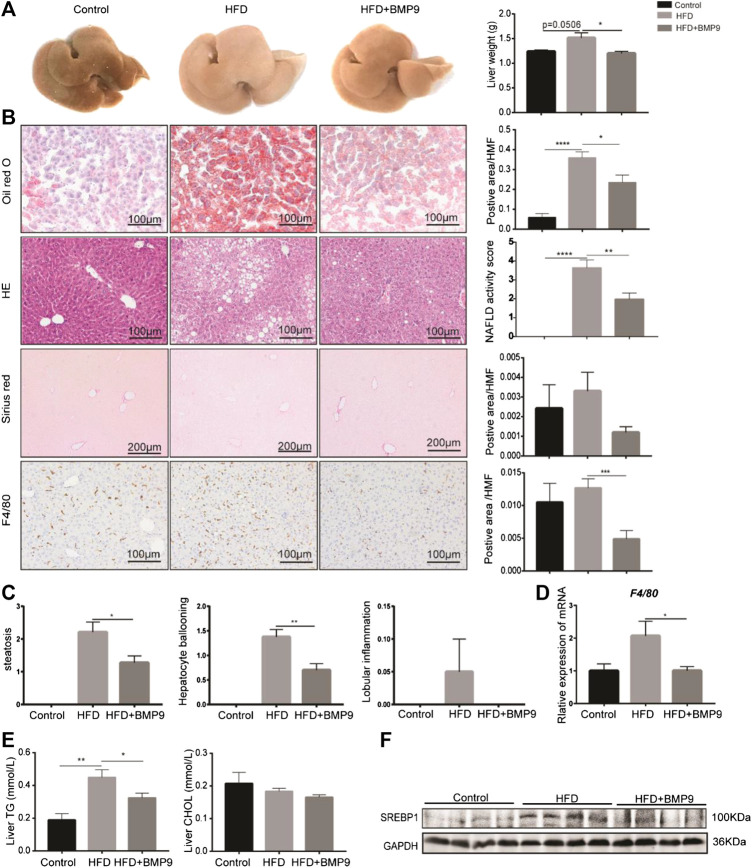
BMP9 treatment attenuates hepatic steatosis in HFD mouse livers. (A) The appearance of the liver and liver weight difference among the three groups. (B) Oil red o staining, HE, sirius red staining of the liver and F4/80 IHC staining in the different groups (original magnification, ×200 or ×100). (C) Histological scoring of steatosis, hepatocyte ballooning and lobular inflammation. (D) The mRNA expression of F4/80 in mouse livers. (E) BMP9 modulated TG but not CHOL levels in the liver. (F) BMP9 downregulated SREBP1 protein expression in the liver. The data are presented as the means ± SEM. Control, n = 6; HFD and HFD+BMP9, n = 8 respectively. *p < 0.05, **p < 0.01, ***p < 0.001, ****p < 0.0001.